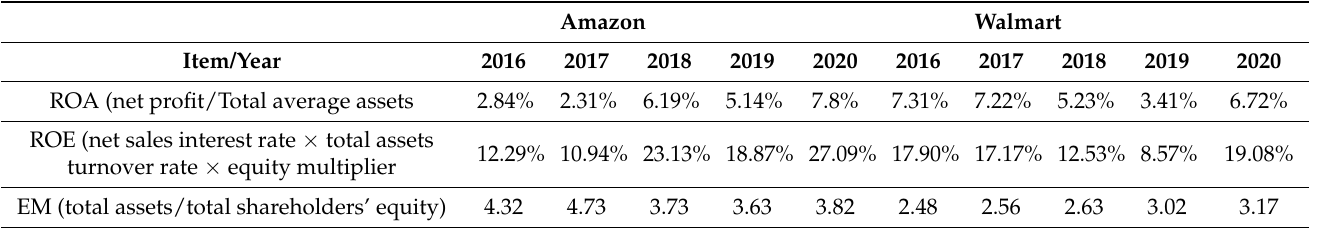
Table 6. Comparative data of ROA, ROE, and EM of Amazon and Walmart